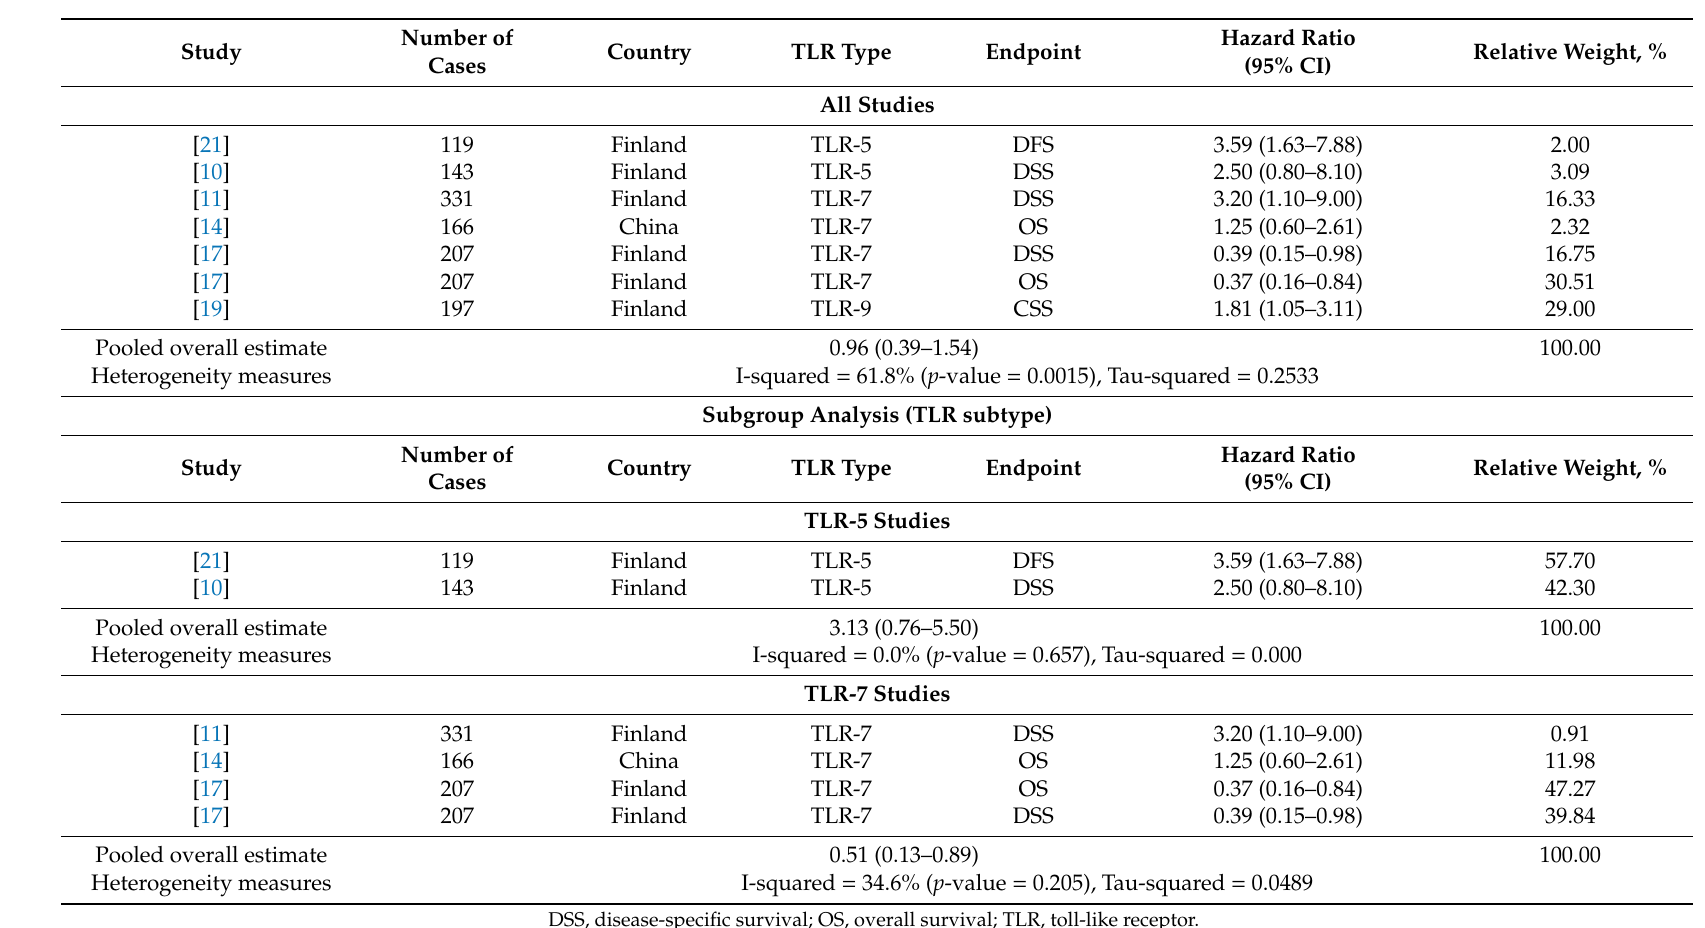
Table 4. Results from the